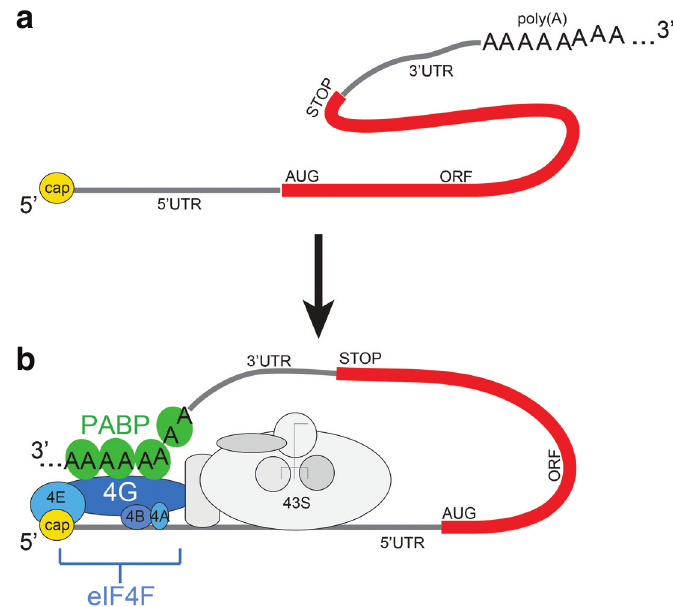
a Figure 1. Canonical 5 ′ -to-3 ′ communication in eukaryotic messenger RNAs (mRNAs). ( a ) Diagram of a mature eukaryotic mRNA. The 5 ′ modified nucleotide cap is shown in yellow, the open reading frame (ORF) in red, and the start codon AUG, translation termination codon (STOP), poly(A) tail, and untranslated regions (UTRs) are labeled. ( b ) Diagram of 5 ′ -to-3 ′ communication in the context of translation initiation. Poly(A)-binding protein (PABP) is shown in green, the eukaryotic initiation factor (eIF) 4F complex is in shades of blue, and its components are labeled. The 43S complex is depicted in shades of gray. poly(A), polyadenylate.